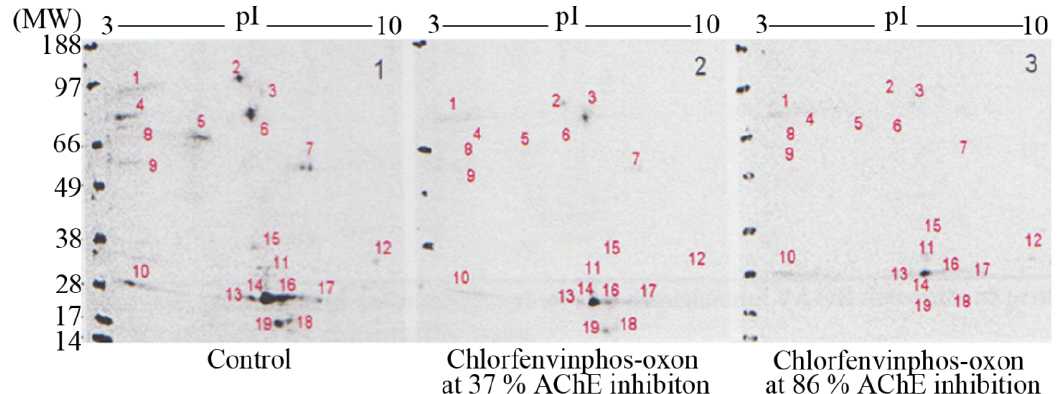
Figure 4. Characterisation of thymus tissue chlorfenvinphos-oxon pesticide targets in vitro after protein resolution by